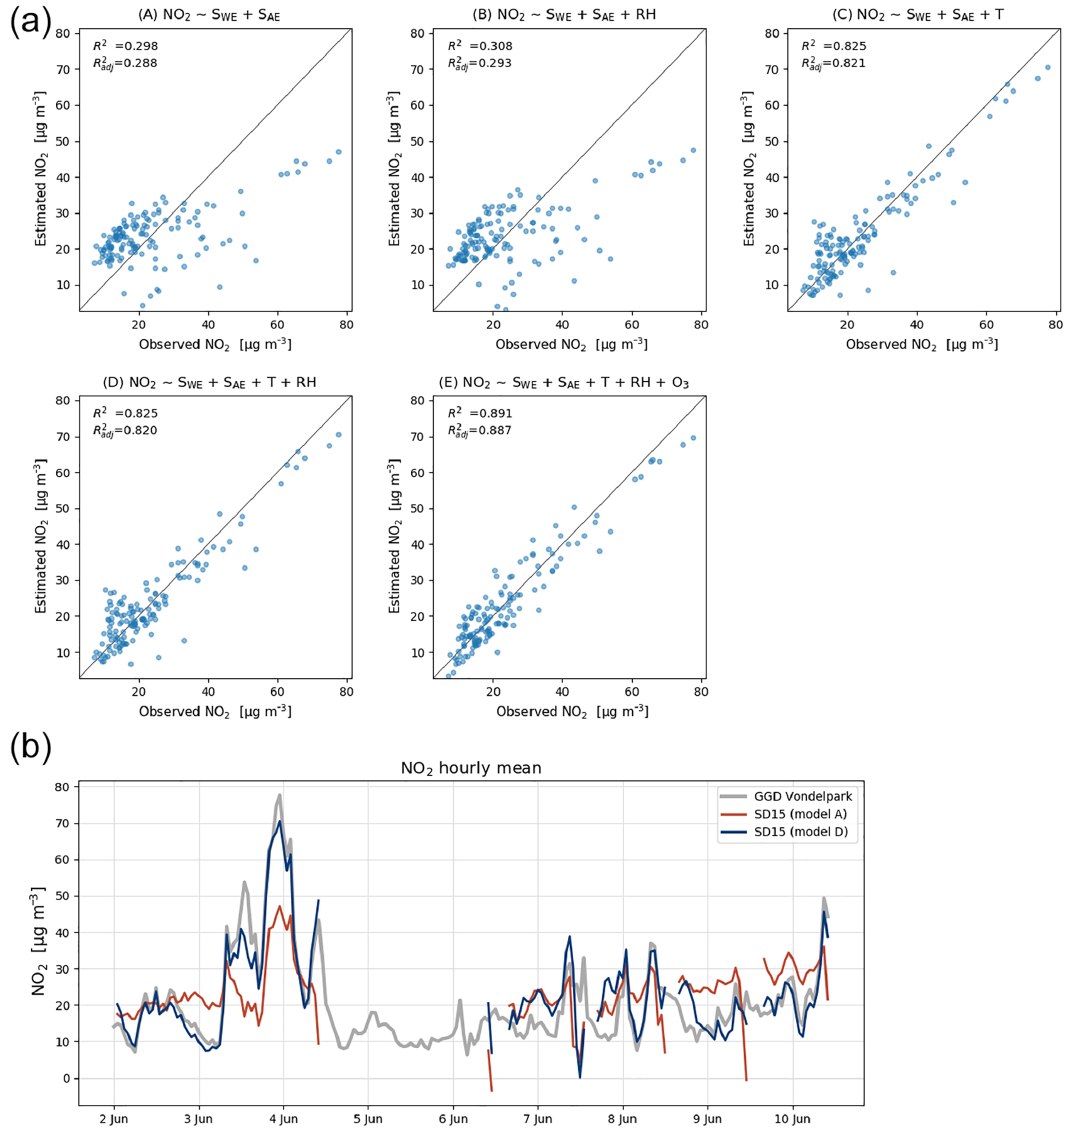
Figure 6. (a) Calibration model results for an average performing sensor (SD15). Bottom row shows the recommended calibration by model D (left), and the results when ozone is included (right). (b) Time series compared to ground truth with calibration parameters of model A and